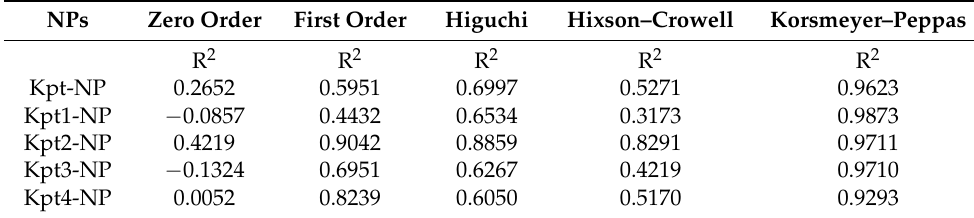
Table 4. Model fitting of in vitro Kpt and Kpt derivatives release kinetics.